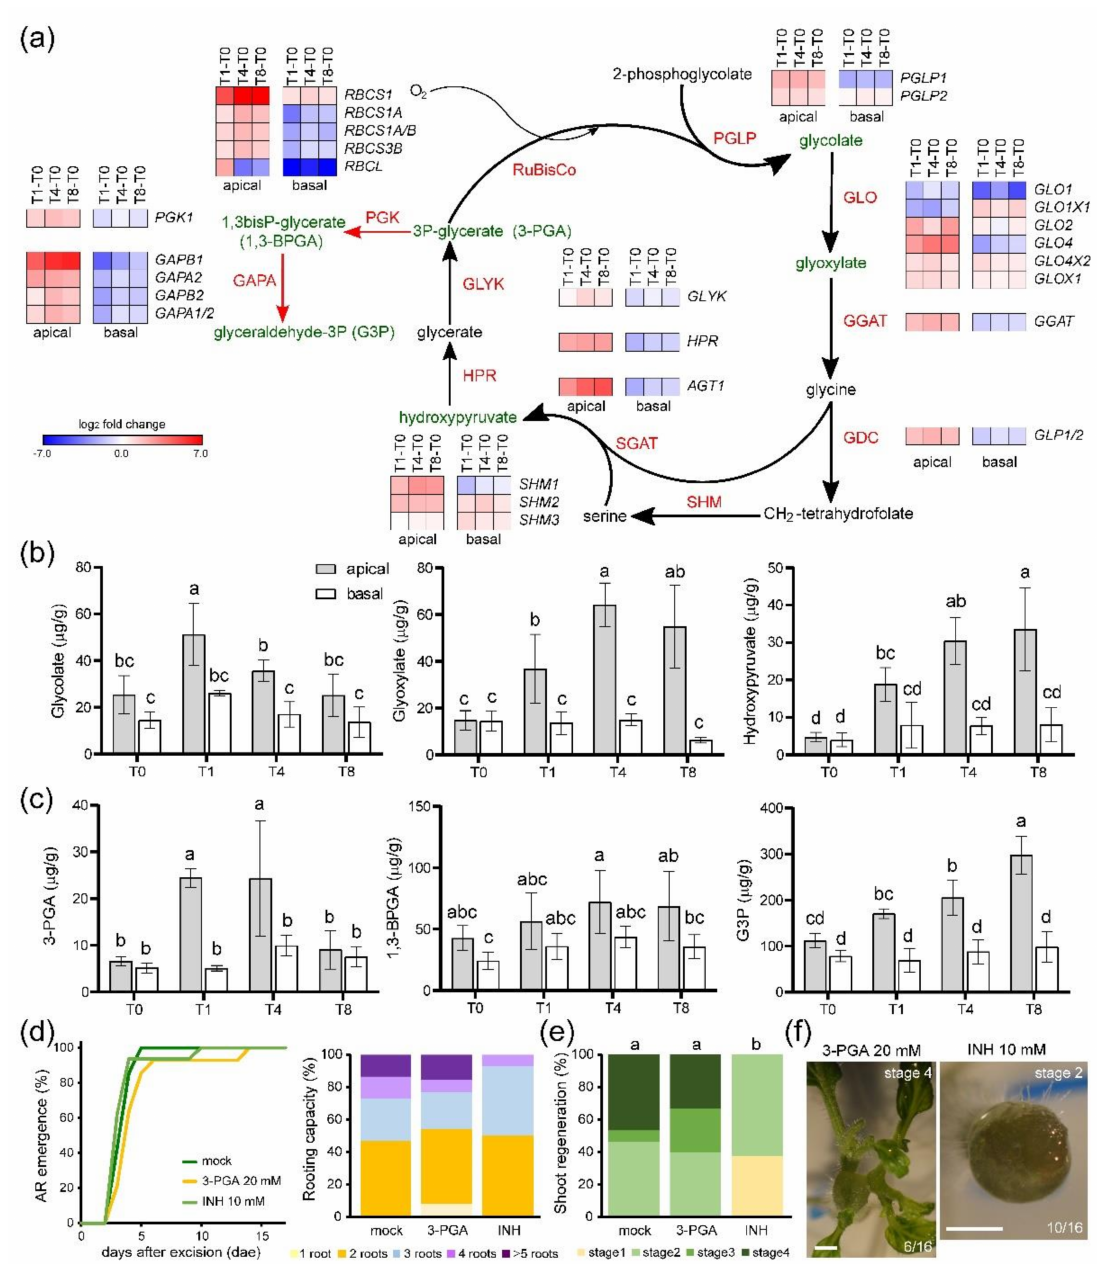
Figure 4. Photorespiration pathway activation during wound-induced organ formation. ( a ) Schematic photorespiration pathway representation. DEGs involved in photorespiration. Genes encoding enzymes of different steps in the pathway are shown: PGLP, phosphoglycolate phosphatase; GLO, glycolate oxidase; GGAT, glutamate-glyoxylate aminotransferase; GDC, glycine decarboxylase complex; SHM, serine hydroxymethyltransferase; SGAT, serine-glyoxylate aminotransferase; HPR, hydroxypyruvate reductase; GLYK, glycerate kinase. Two enzymes of the Calvin–Benson cycle are also included: PGK, phosphoglycerate kinase and GAPA, glyceraldehyde-phosphate dehydrogenase; ( b , c ) endogenous levels of several metabolites of the photorespiration pathway in the apical and basal regions of hypocotyl explants throughout the studied time course. Metabolites are indicated in green in panel ( a ); ( d ) AR emergence; ( e ) rooting capacity of hypocotyl explants at 14 dae; ( f ) representative images of de novo organ formation in the apical region of hypocotyl explants grown on SGM that were supplemented with either 20 mM 3-PGCA or 10 mM isoniazide (INH) in their apical region. Different letters indicate significant differences ( p -value < 0.01) between the assay conditions. Gene annotations in panel ( a ) are found in Table S6. Scale bars: 1 mm. Expression values are log 2 fold